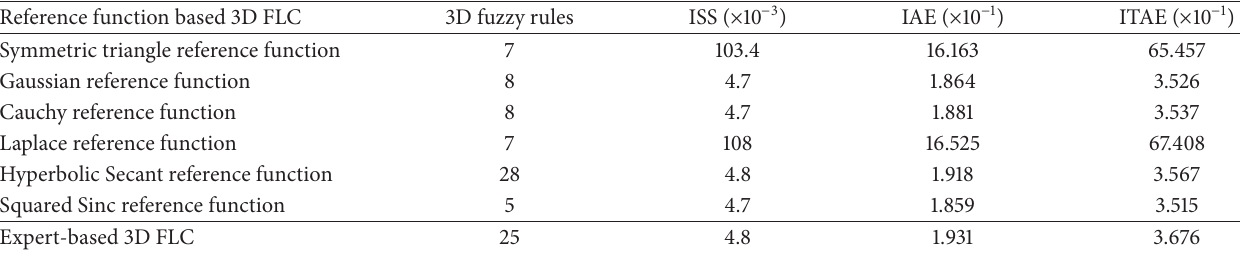
Table 2: Performance